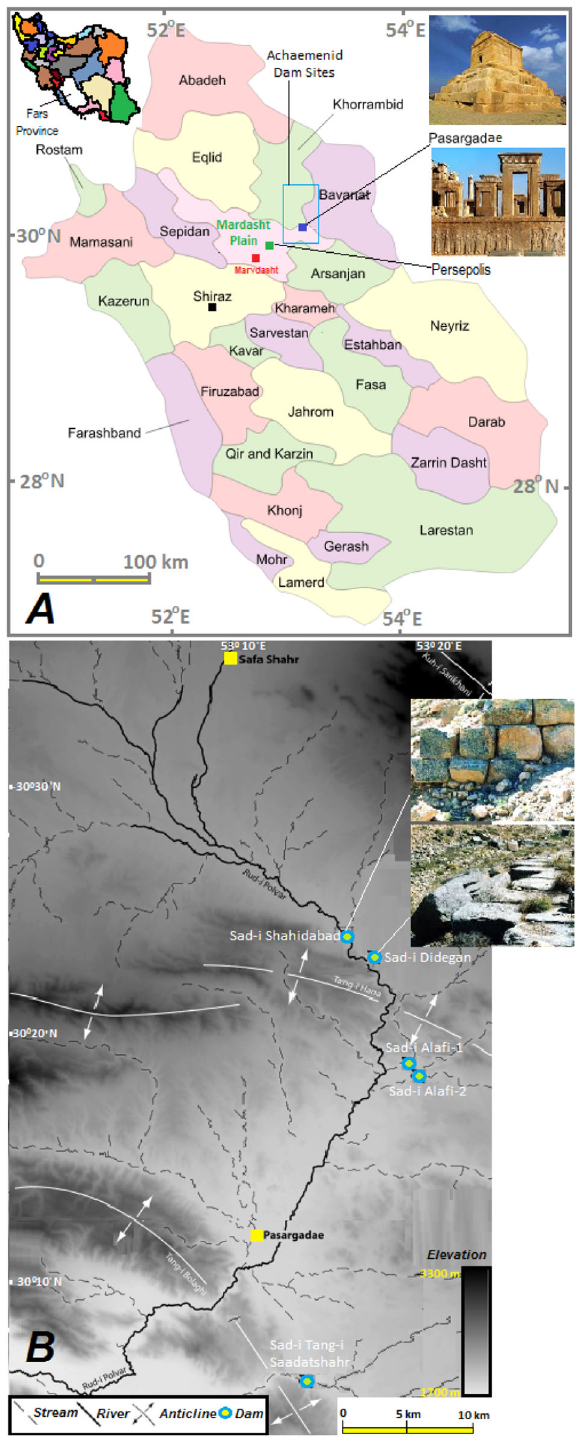
Fig. 3 Geographical location of Pasargadae and Persepolis and the Achaemenid dams in the Marvdasht Plain, Fars Province. A Surrounded by the southern Zagros Mountains, the 160-ha archaeological site of Pasargadae, the earliest capital of the Achaemenid Empire, is located on the Marvdasht Plain in Fars Province. Located 40 km southwest of Pasargadae, Persepolis was an impressive palace complex and the ceremonial capital of the Achaemenid Empire. Shiraz, the capital of Fars Province is located 60